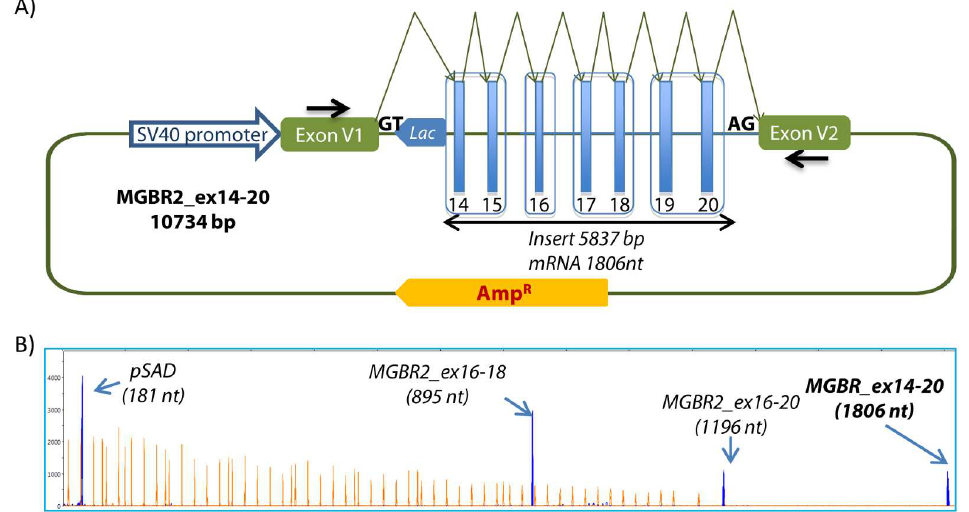
Fig 1. Structure and functional analysis of the minigene MGBR2_ex14-20. A) Structure of the minigene MGBR2_ex14-20 (slashes indicateshortenedintrons): [IVS14 (328 pb)–EX14(428 pb)–IVS14(1139 pb)— EX15 (182 pb)–IVS15(358 pb) // IVS15 (333 pb)–EX16(188 pb)–IVS16(234 pb) // IVS16 (181 pb)–EX17(171 pb)–IVS17(485 pb)–EX18(355 pb)–IVS18(314 pb) // IVS18 (235 pb)–EX19(156 pb)–IVS19(398 pb)–EX20 (145 pb)–IVS20(207 pb)]. Boxes highlightthe 4 different cloningsteps of this minigene. The expectedsplicing reactions in eukaryoticcells are indicatedby arrows. B) Splicingfunctionalanalysisof the empty vector pSAD and the final (14–20)and intermediate (16–18, 16–20)constructs in MCF-7 cells. The four electropherograms were overlaid.cDNAs were amplifiedwith vector exon specific primers SD6-PSPL3_RTFW and RTpSAD-RV (arrows within vector exons V1 and V2 above). Full-lengthtranscripts are shown as blue peaks and the Genescan Liz-1200size standard is shown as orange/faintpeaks. Fragment sizes (bp) and relative fluorescent units are indicatedon the x- and y-axes,